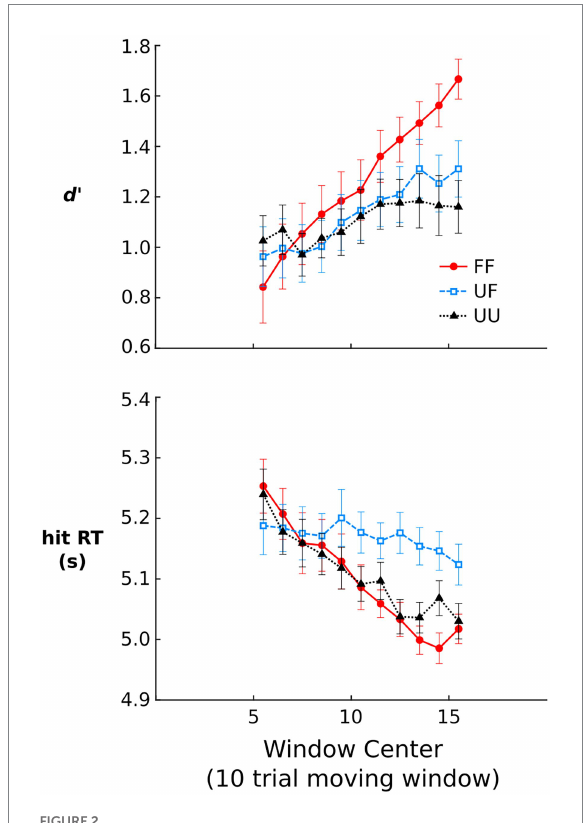
FIGURE 2 Repetition detection phase data. Signal detection d ‘ and median RT for hit trials. Signal detection d ‘ was computed using running average hit and false alarm rates where each rate reflected the contribution of 10 different trials. Median response times (RT) are shown for repeating trials that were correctly detected. All error bars represent within-subject standard errors of the mean (Cousineau,